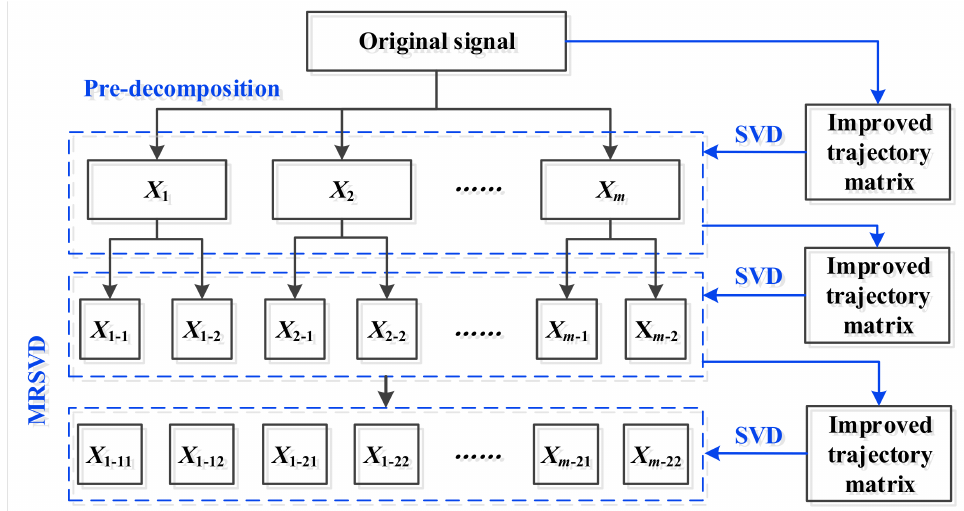
Figure 1. The structure of